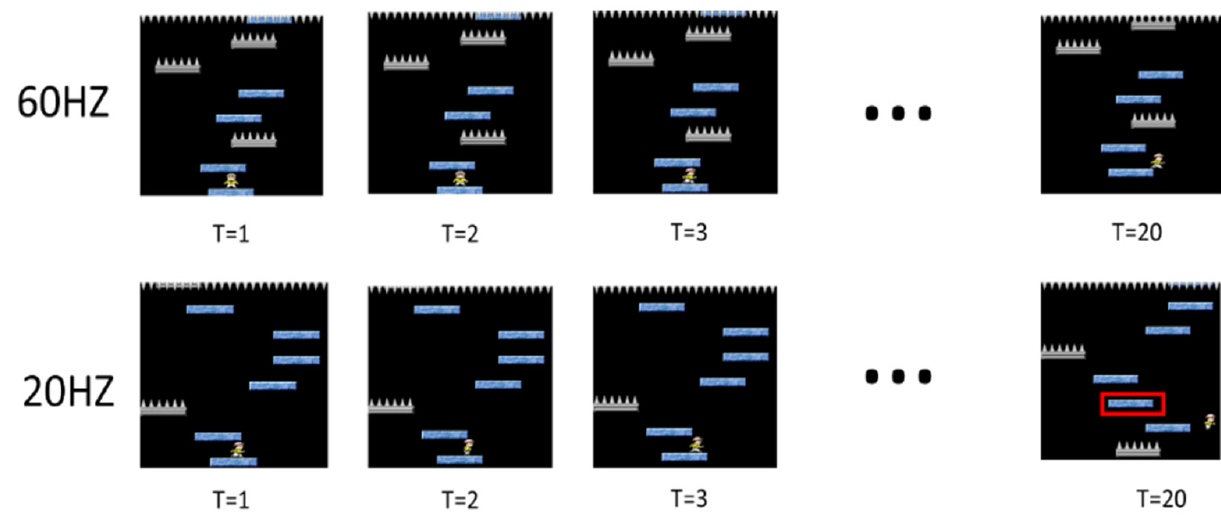
Figure 8. Effect of sample frequency.